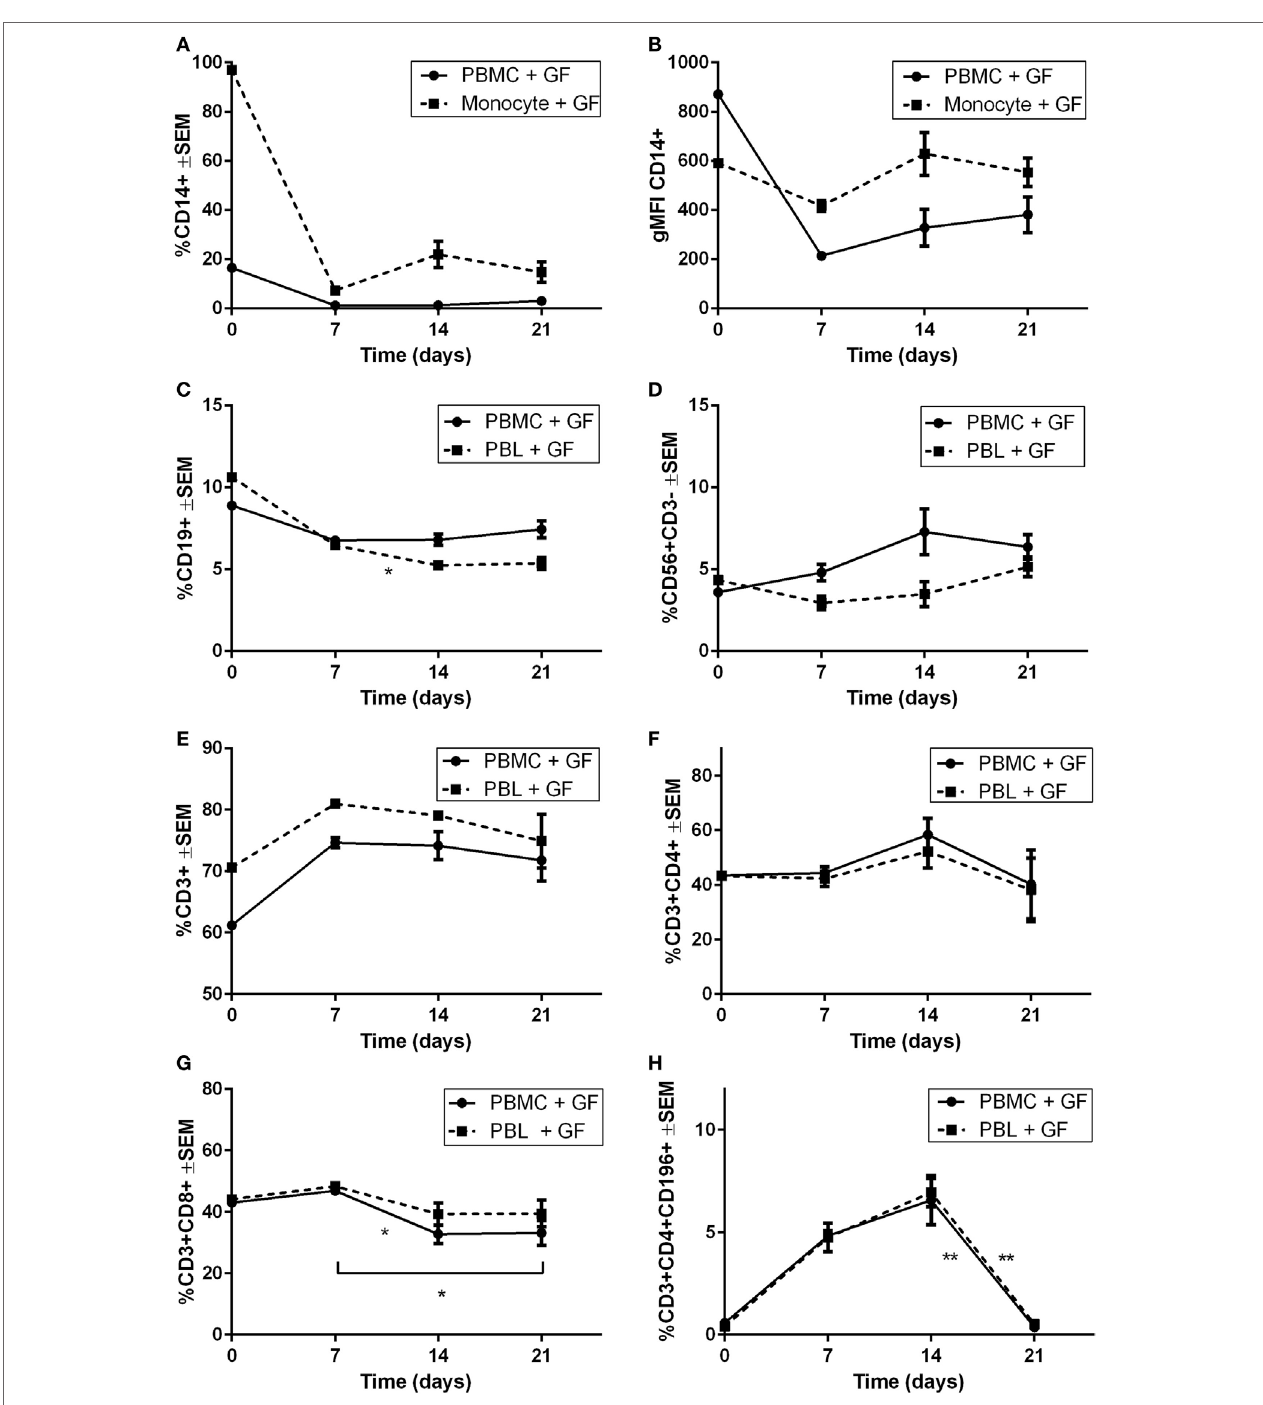
FigUre 5 | Survival and retention of peripheral blood lymphocytes in coculture of gingival fibroblast (GF) over time. Percentages of cells present in cocultures. (a) The proportion of CD14 + cells (percentage ± SEM) present in GF cocultures with peripheral blood mononuclear cells (PBMCs) (solid line) and monocytes (dotted line). (B) Geometric mean fluorescence intensity (gMFI) of CD14 + cells over time of GF cocultures with PBMCs (solid line) and monocytes (dotted line). No significant difference of CD14 + percentage (a) or gMFI (B) after 7 days was observed. Percentages ± SEM of (c) CD19 + , (D) CD56 + CD3 − , (e) CD3 + , (F) CD3 + CD4 + , (g) CD3 + CD8 + , (h) CD3 + CD4 + CD196 + cells present in GF cocultures with PBMCs (solid line) and peripheral blood lymphocytes (PBLs) (dotted line). No significant increase or decrease of percentage (D) CD56 + CD3 − , (e) CD3 + , (F) CD3 + CD4 + cells is shown over time in both cocultures of PBMCs and PBLs. (c) A significant decrease of CD19 + cells after 7 days is shown in PBL cocultures. Significant decrease of CD3 + CD8 + cells is shown after 7 days in PBMC cocultures. A significant decrease of CD3 + CD4 + CD196 + cells after 14 days is shown in PBMC and PBL cocultures. Time point 0 represents monocultures of (a,B) monocytes, (c–h) PBMCs, and PBLs. All significant differences were tested after 7 days since time point 0 represents a characterization of one experiment. n = 10 GF donors, n = 2 buffy coats, * p < 0.05, ** <